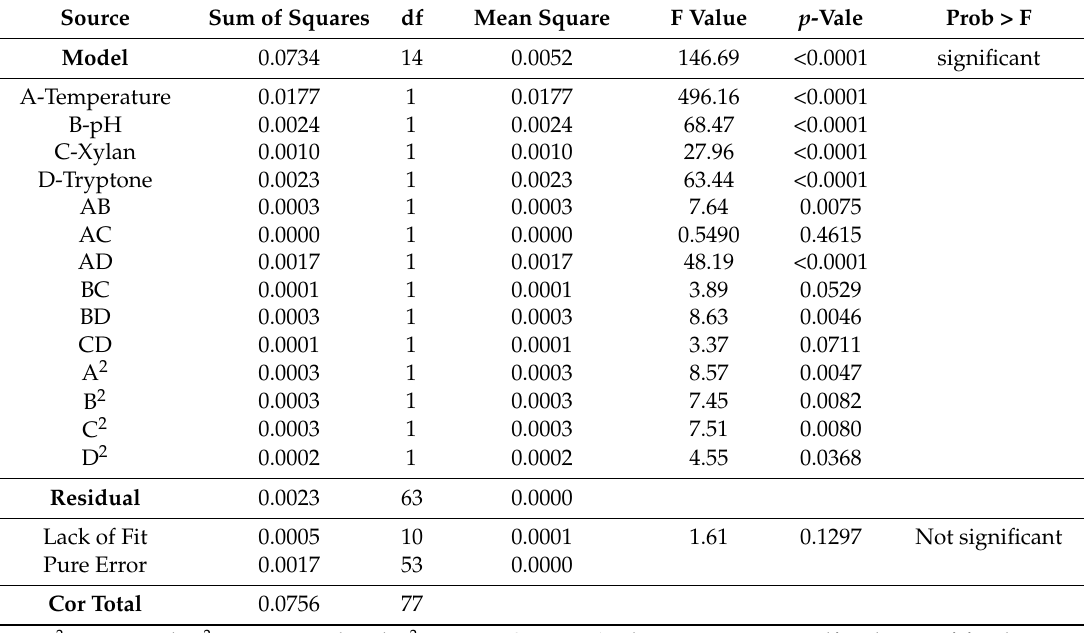
Table 3. ANOVA for the xylanase activity as a function of independent variables as obtained in the simulation. The main factor effects, and two factor interaction effects having an effect on the xylanase activity are